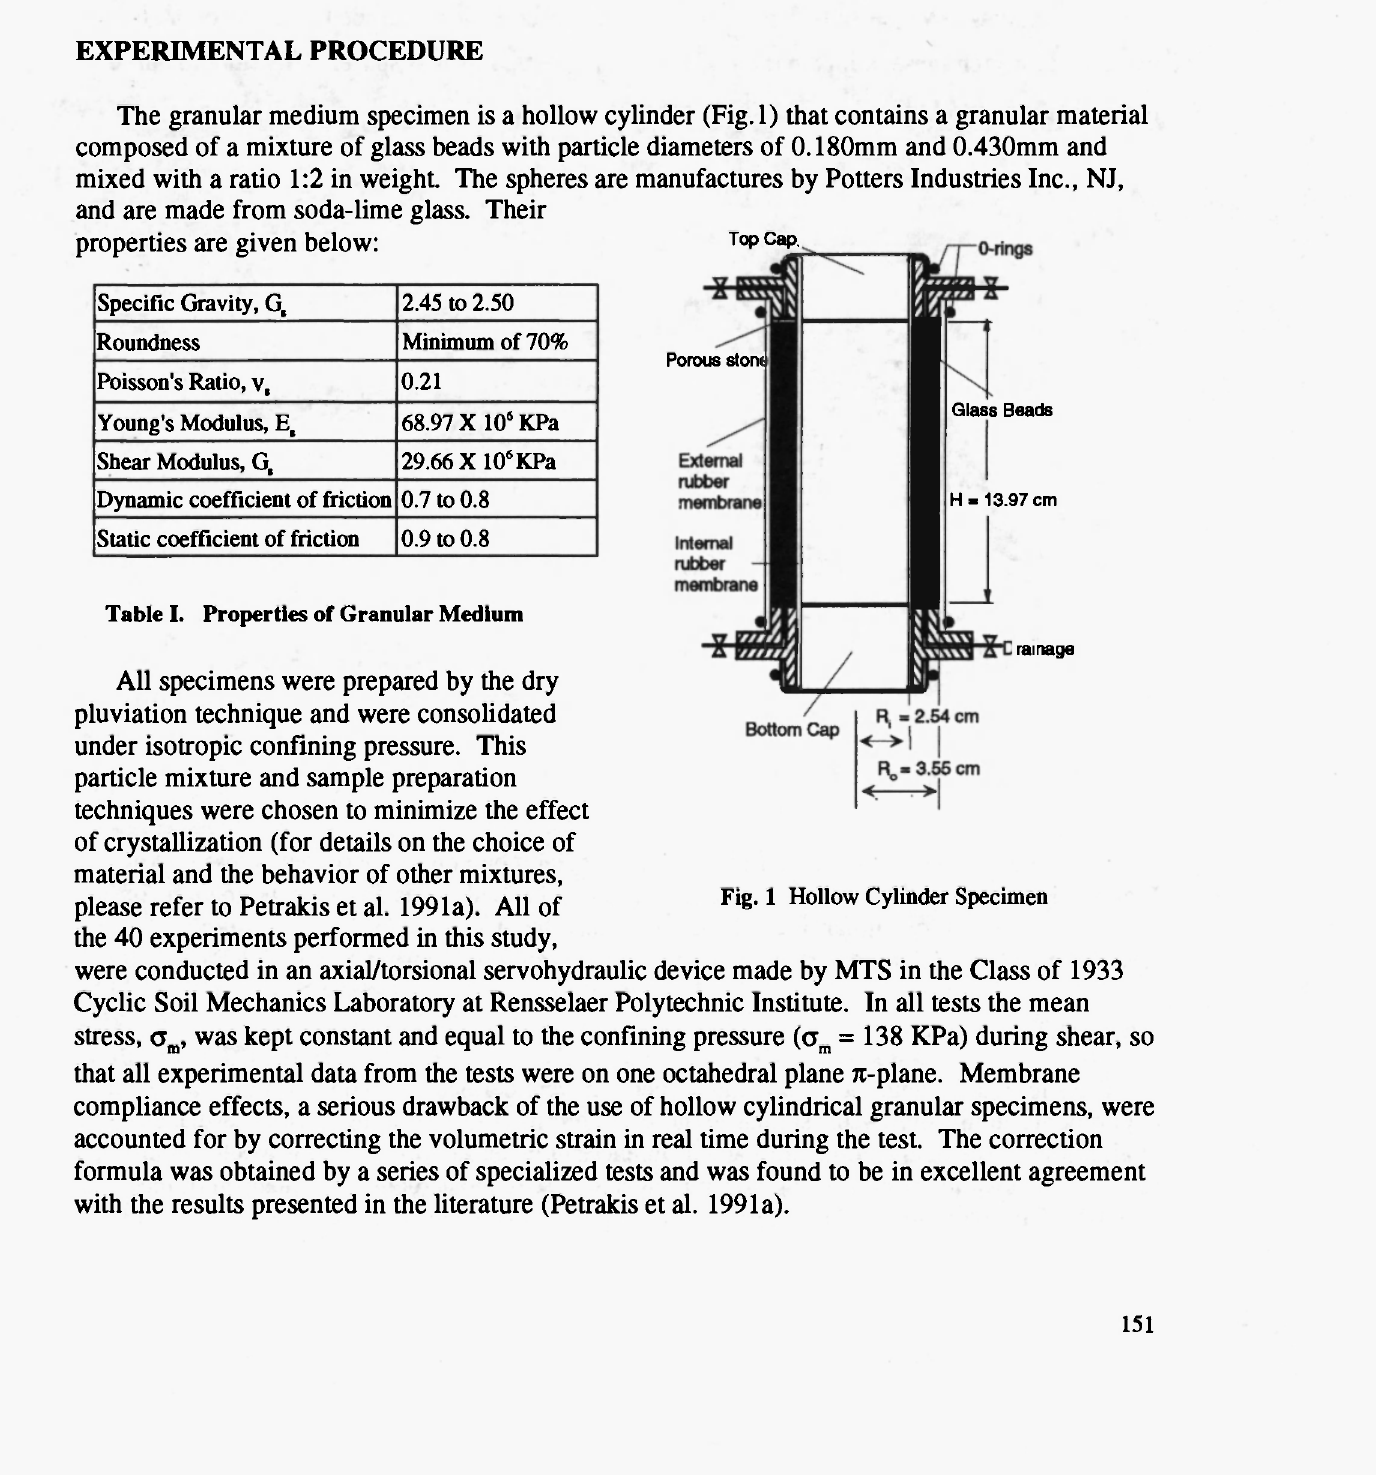
Table I. Properties of Granular Medium